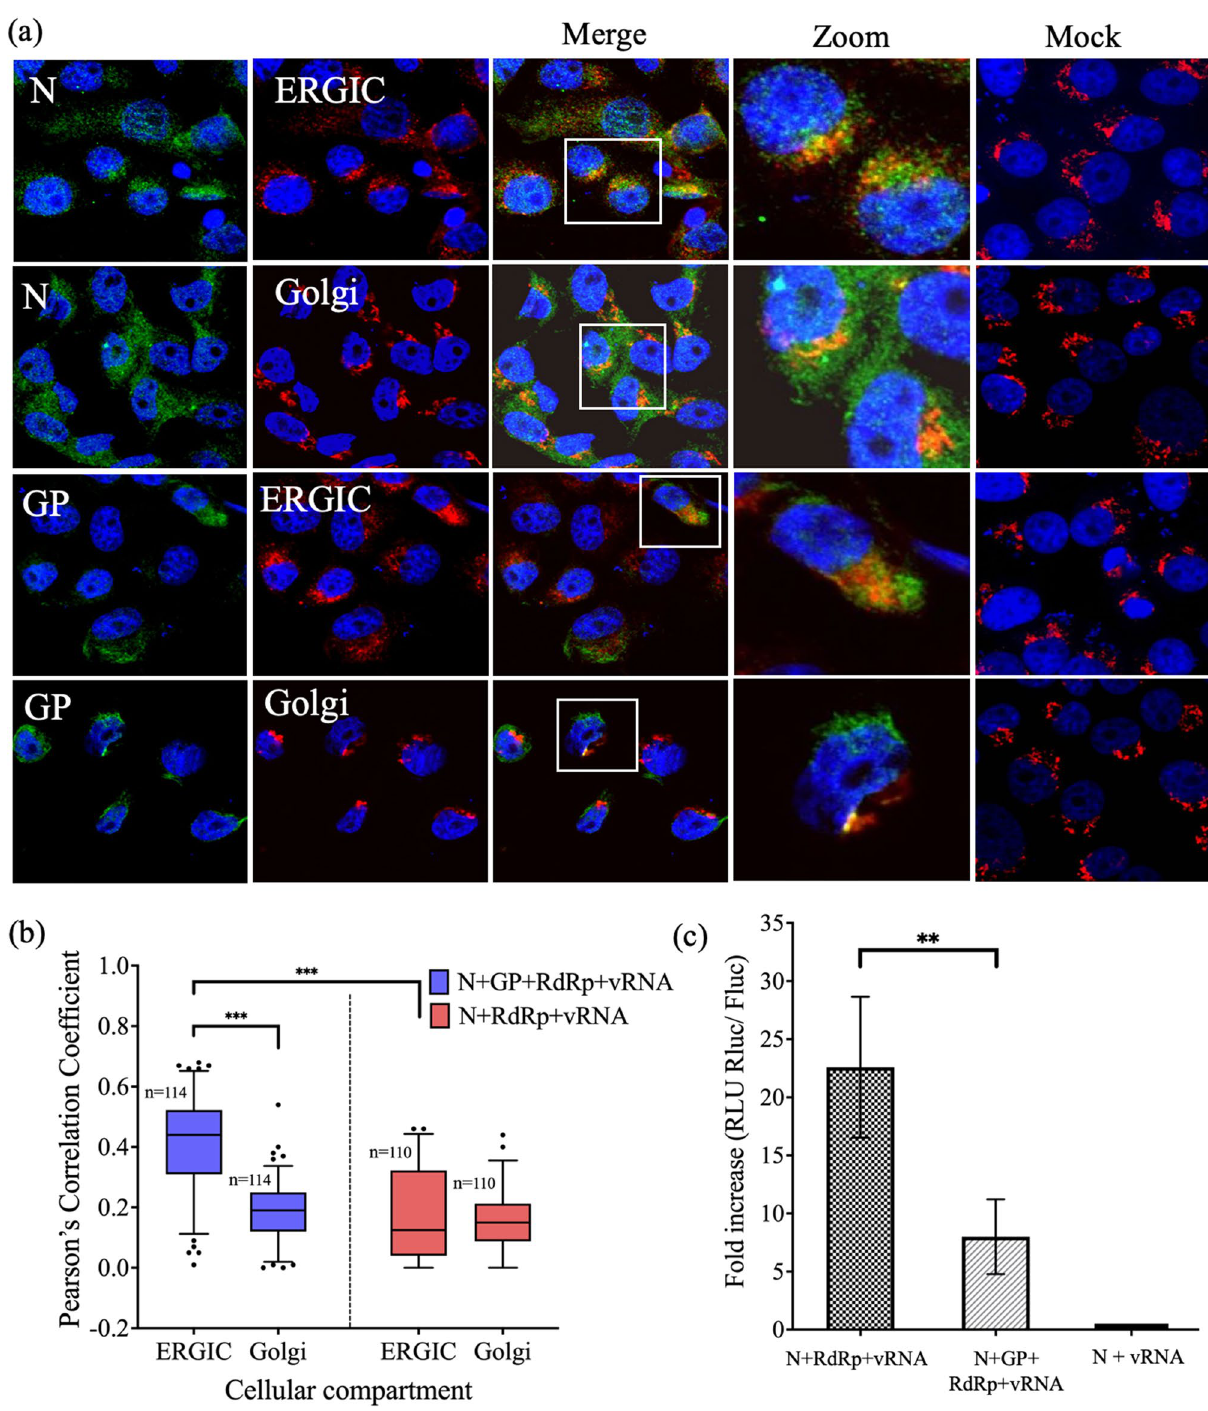
Figure 2. Subcellular localization of N protein together with all viral components. (a) Vero E6 cells were transfected with pCAGGS- SFTSV-N, pCAGGS-SFTSV-GP, pCAGGS-SFTSV-RdRp, and vRNA-Rluc and subsequently fixed at 24 hpt. The cells were stained with antibodies against N protein or GP (green) and ERGIC or Golgi organelle markers (red), and the nuclei were stained with DAPI (blue). The yellow areas in the merged images show the cellular localization of proteins with organelle markers. Magnification of the merged area is shown on the right side of the merged image. The mock-transfected cells are shown as mock images. (b) Localization of N, ERGIC, and Golgi apparatus shown in (a) was analyzed using ImageJ (corresponding to * P < 0.05, ** P < 0.01, and *** P < 0.001). Number of cells = n. (c) Detection of transcriptional activity using a minigenome assay. BHK/T7-9 cells were transfected with pCAGGS-SFTSV-N, pCAGGS-SFTSV-RdRp, and vRNA-Rluc or pCAGGS-SFTSV-N, pCAGGS-SFTSV-RdRp, vRNA-Rluc, and pCAGGS-SFTSV-GP. The luciferase activities were compared with that of N + vRNA-Rluc (without RdRp) as a negative control. The activity of Rluc was standardized by Fluc activity (transfection control). Results are shown as fold increases (RLU Rluc/Fluc) in the bar graph with standard deviations of the means. The statistical significance between RdRp and without RdRp in different combinations was assessed using the Student’s t-test (corresponding to *P < 0.05 and ** P <